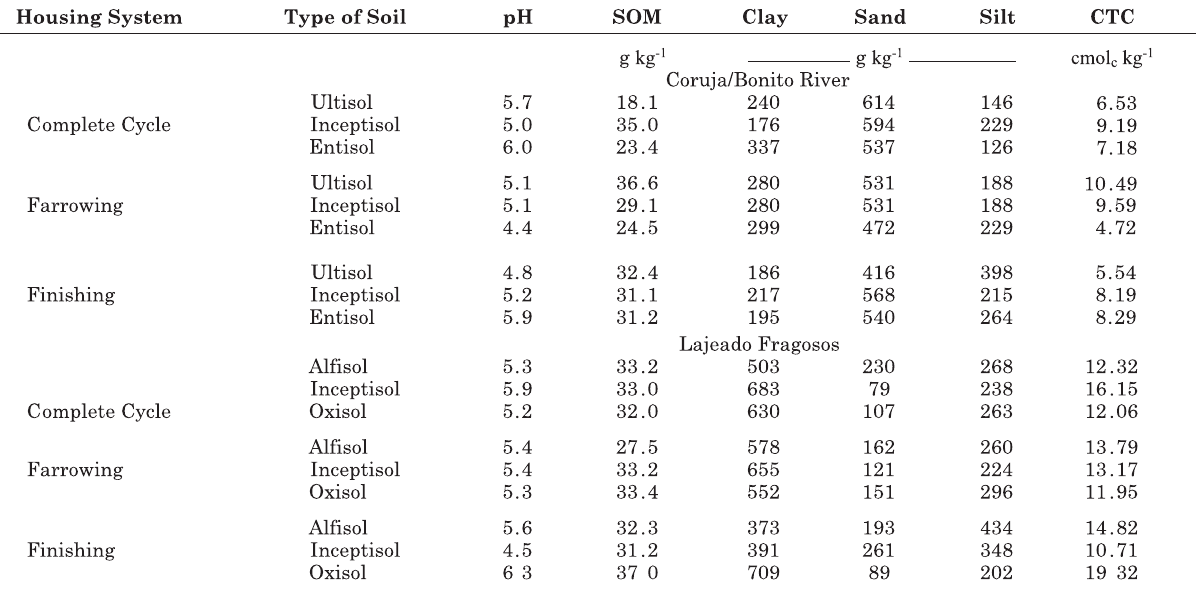
SOM: Soil Organic Matter; CTC: Cation Exchange